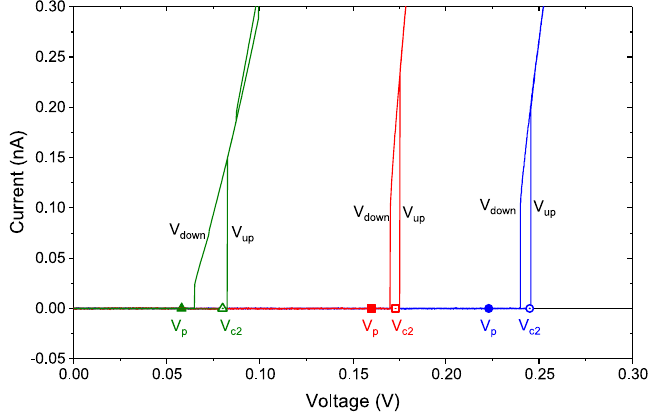
Figure 2. Current-voltage characteristics. Different color correspond to different samples. Each sample demonstrates the hysteretic behavior around the threshold voltage V c 2 , the black arrows indicate the direct and reversed directions of the voltage change. The filled symbols show the position of V p relative to the threshold voltage V c 2 , presented by empty symbols.